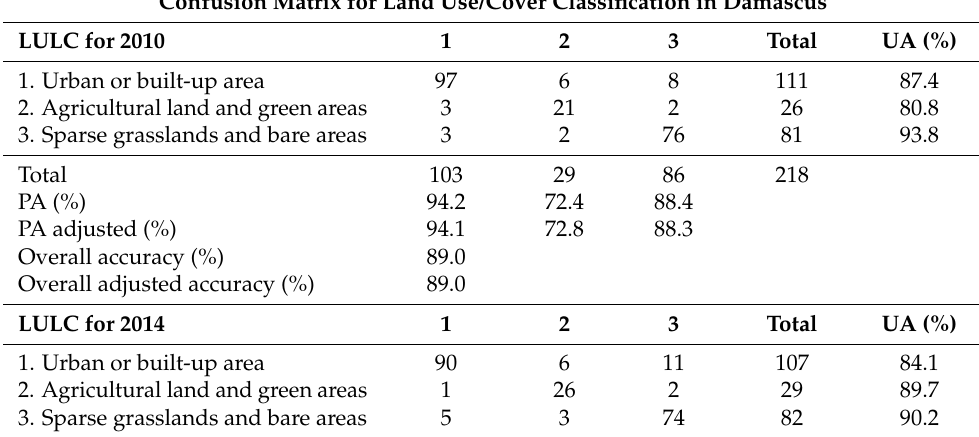
Table A2. Confusion matrices containing the (adjusted and not-adjusted) accuracy assessment of the LULC categories in Damascus and Aleppo using a (slightly modified) stratified sample for the years 2010, 2014, and 2018. Here, the producer’s accuracy is PA and the user’s accuracy is UA. Confusion Matrix for Land Use/Cover Classification in Damascus LULC for